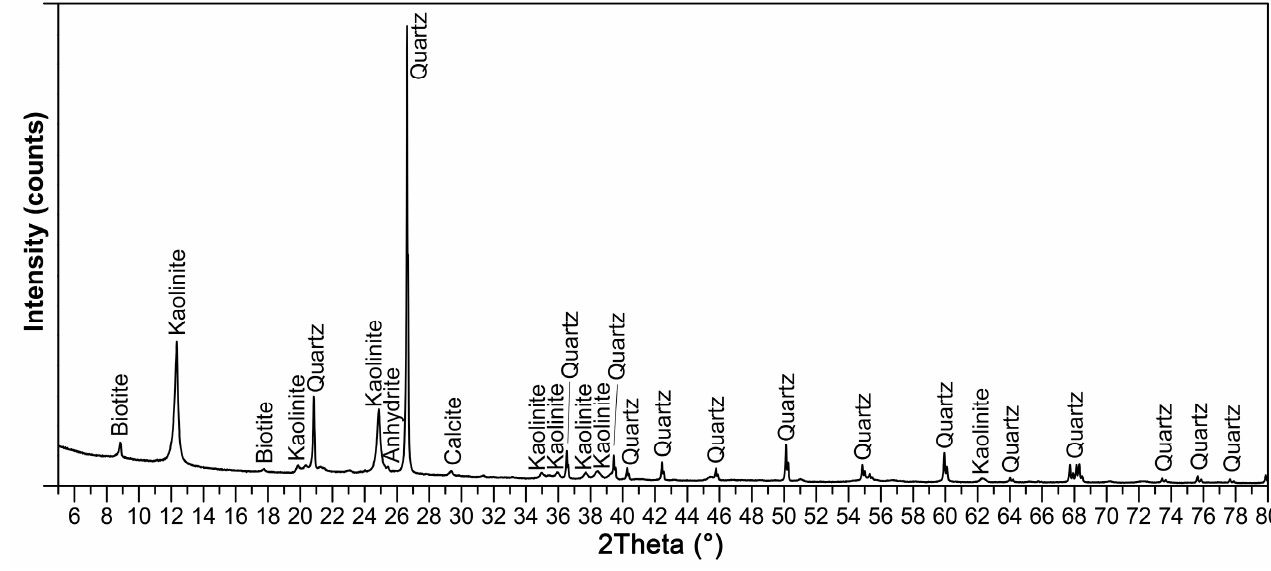
However, the presumed formation of a hydraulic bond via calcium-silicate-hydrate (C-S-H gel) and ettringite [6] was not confirmed by an X-ray diffraction analysis (Figure 7). However, authors [6] used high-calcium fly ash with a much higher CaO content (66.76 wt. %), which corresponds to the composition of Portland cement [25]. Only phases present in individual input raw materials (kaolin, quartz sand and CCFA) were discovered in the KQFF dried green body. Hydration of anhydrite in KQF and KQFF bodies is expected [26]. Figure 8 represents the difference in porosity and microstructure of dried green bodies depending on the amount of CCFA addition (0, 10 and 20 wt. %).